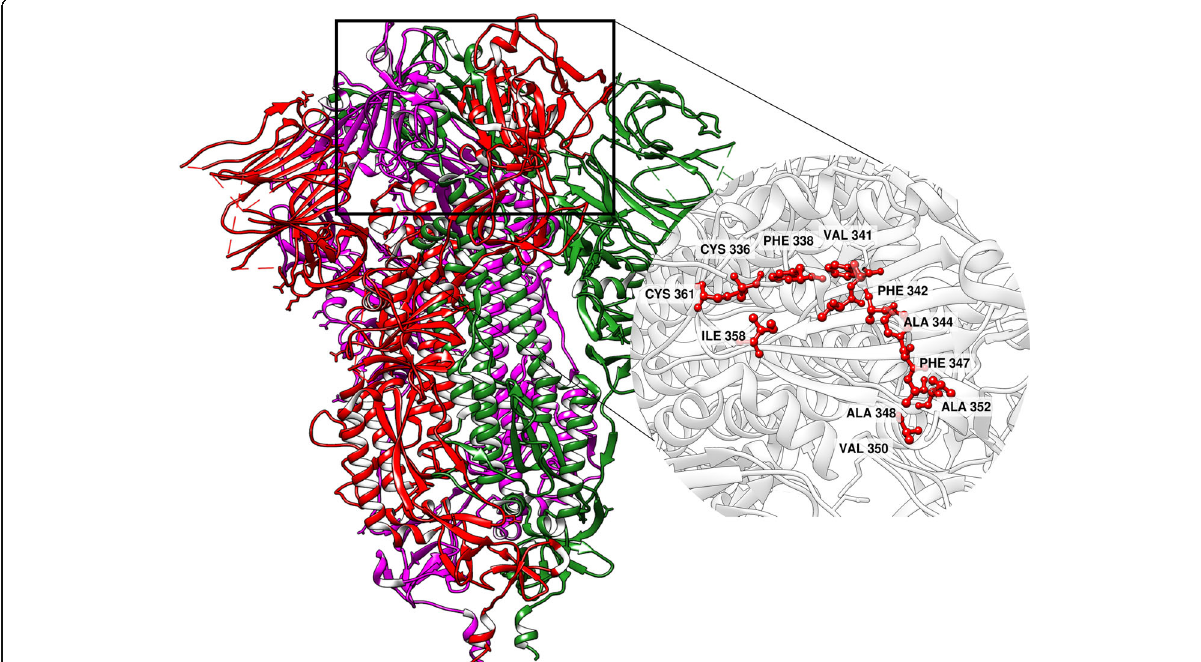
Fig. 1 3D structure of 6X6P (Spike Protein, Trimeric structure) with chain A (Red), chain B (green), and chain C (magenta). Binding region 1 with its amino acids is